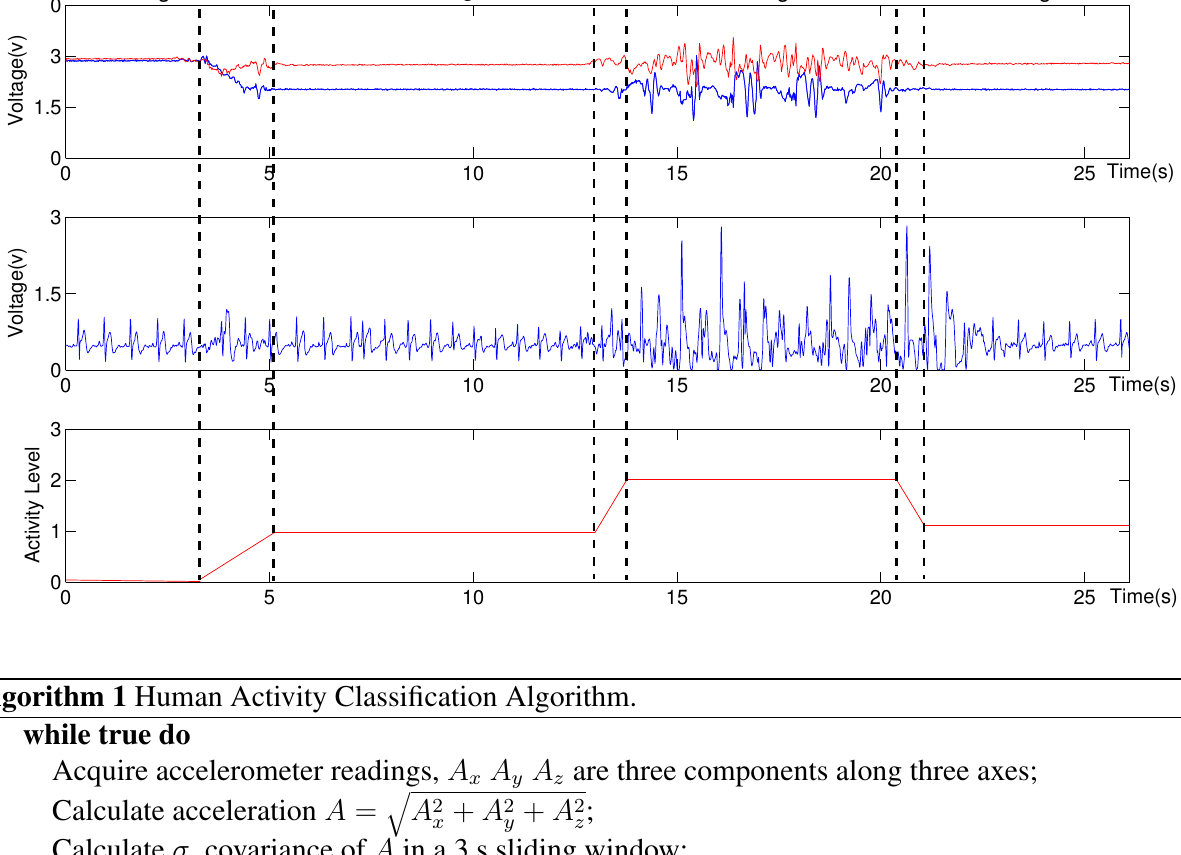
Figure 17. Human activity classification based on the accelerometer measurements. The dashed lines represent the human activities and the transitions between them.